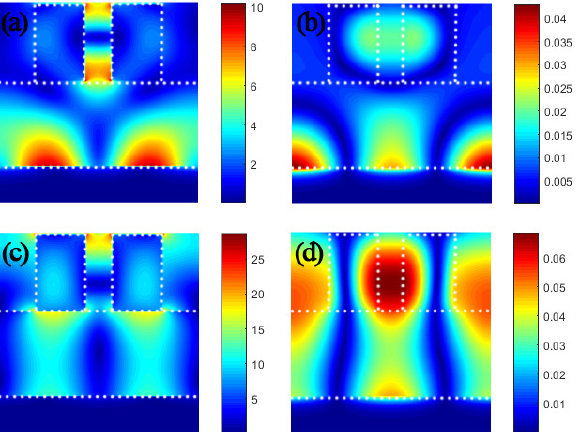
Figure 3. ( a , b ) Distribution of electric and magnetic fields at λ 1 = 865.295 nm. ( c , d ) Distribution of electric and magnetic fields at λ 2 = 967.645 nm. The white dotted lines describe the structure of the absorber.